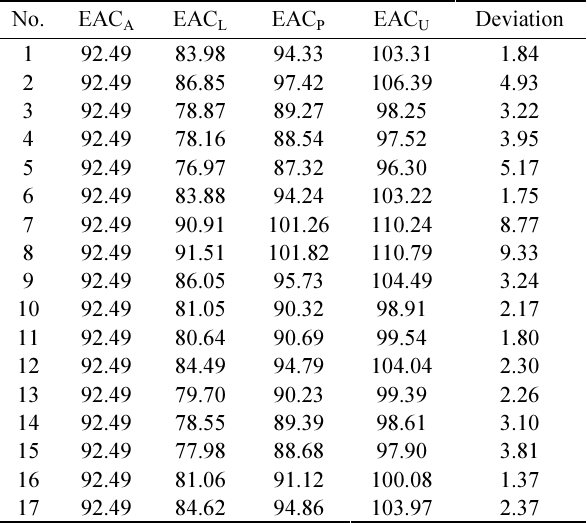
Table 6. Interval Estimation of EAC for project 13